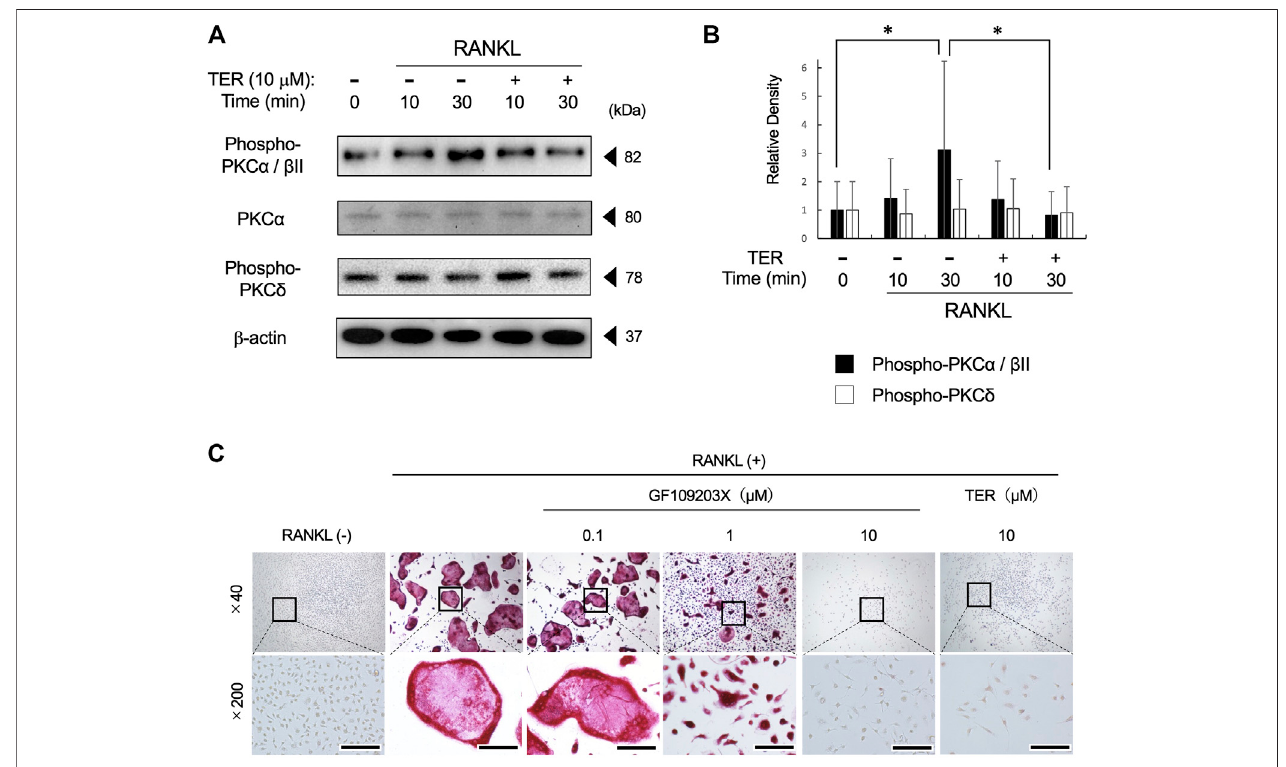
FIGURE 6 | Synthetic TER suppressed RANKL-induced PKC α / β II phosphorylation and RANKL-induced osteoclastogenesis. (A) Mouse BMMs (1 × 10 5 cells/well) were treatedwithRANKL/M-CSF(100 ng/mleach)inthepresenceandabsenceofsyntheticTER(10 μ M)for30 minbeforeRANKLstimulation.Totalcellextractswerepreparedand subjected toWestern blotting usinganti – phospho-PKC α / β ǁ , total-PKC α , phosphor-PKC δ , and β -actin. (B) The relativedensity was measured using ImageJ software. Columns represent the mean results of the experiments carried out in triplicates, and the bars represent the SD ( n (cid:1) 3, * p < 0.05, ANOVA/Tukey – Kramer test). (C) Representative images of a 48-well plate showing the effects of the PKC inhibitor, GF102903X (0.1 – 10 μ M), and synthetic TER (10 μ M) on RANKL-induced mBMM-derived osteoclast-like cell formation stained with tartrate-resistant acid phosphate (TRAP). Numbers next to the images indicate the magni fi cation; scale bar: 200 µm (at a × 200 magni fi cation).